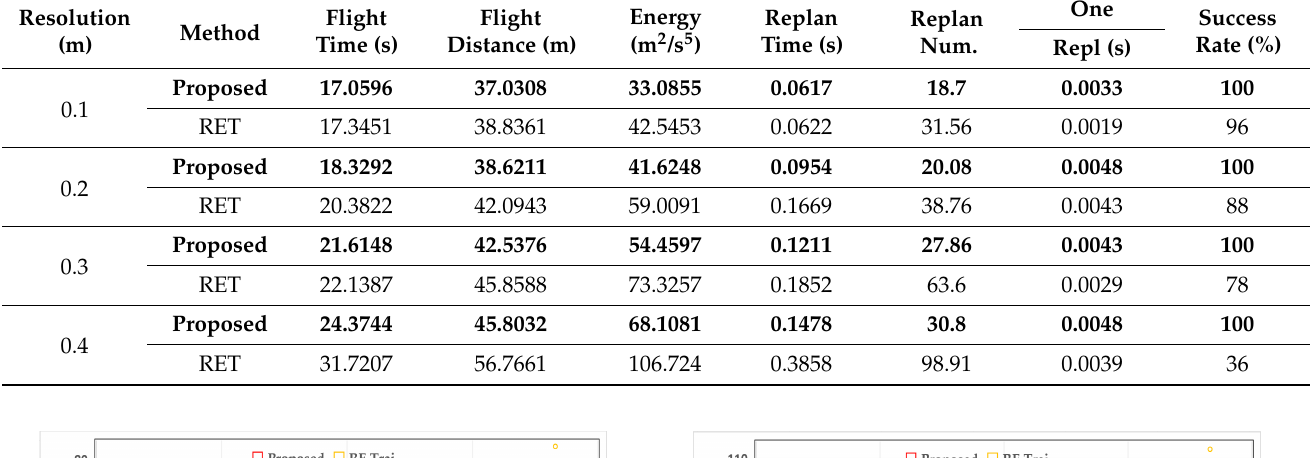
Table 2. The comparisons of two planning method.